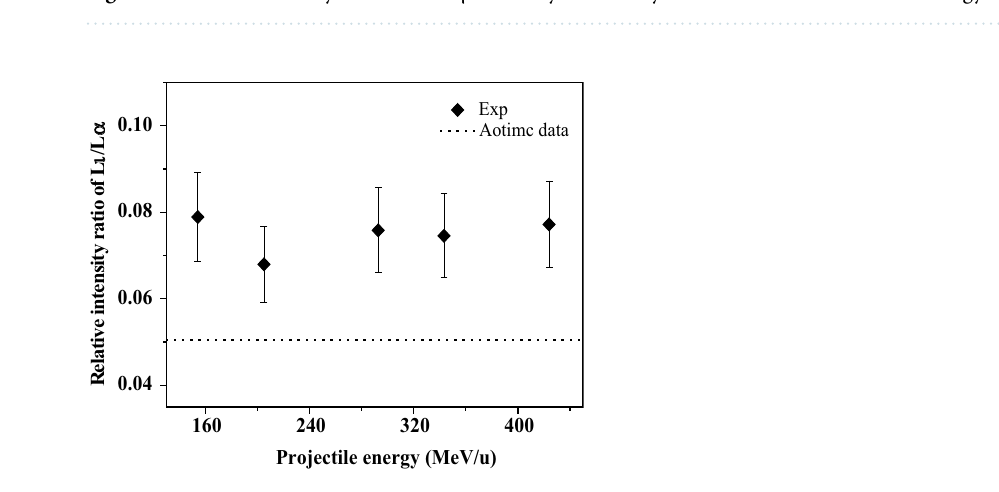
Figure 3. Relative intensity ratios of Au Lβ–Lα x-ray induced by C 6+ ions at different incident energy.